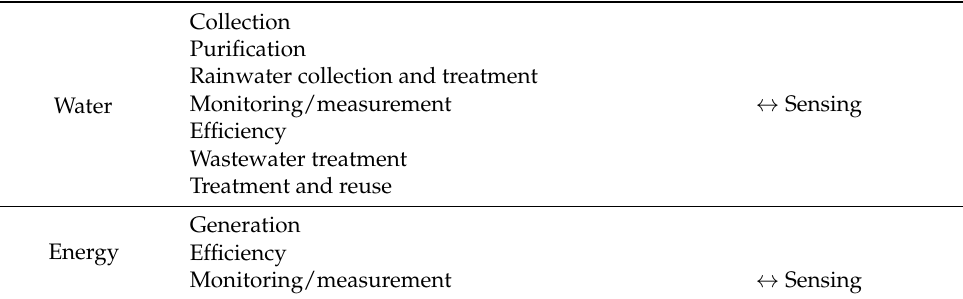
Table 7. The identified water and energy “needs” from